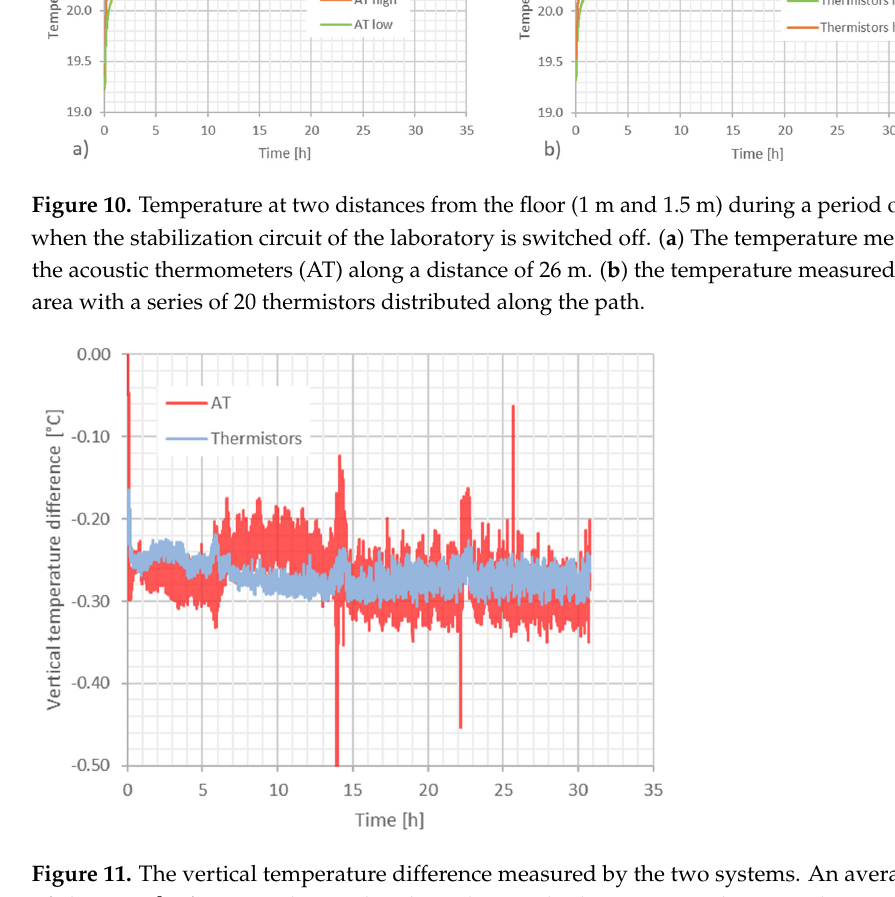
Figure 11. The vertical temperature difference measured by the two systems. An average gradient of about 0.3 °C/0.5 m is observed in the 30 h period. The agreement between the systems is better than 0.1 °C.